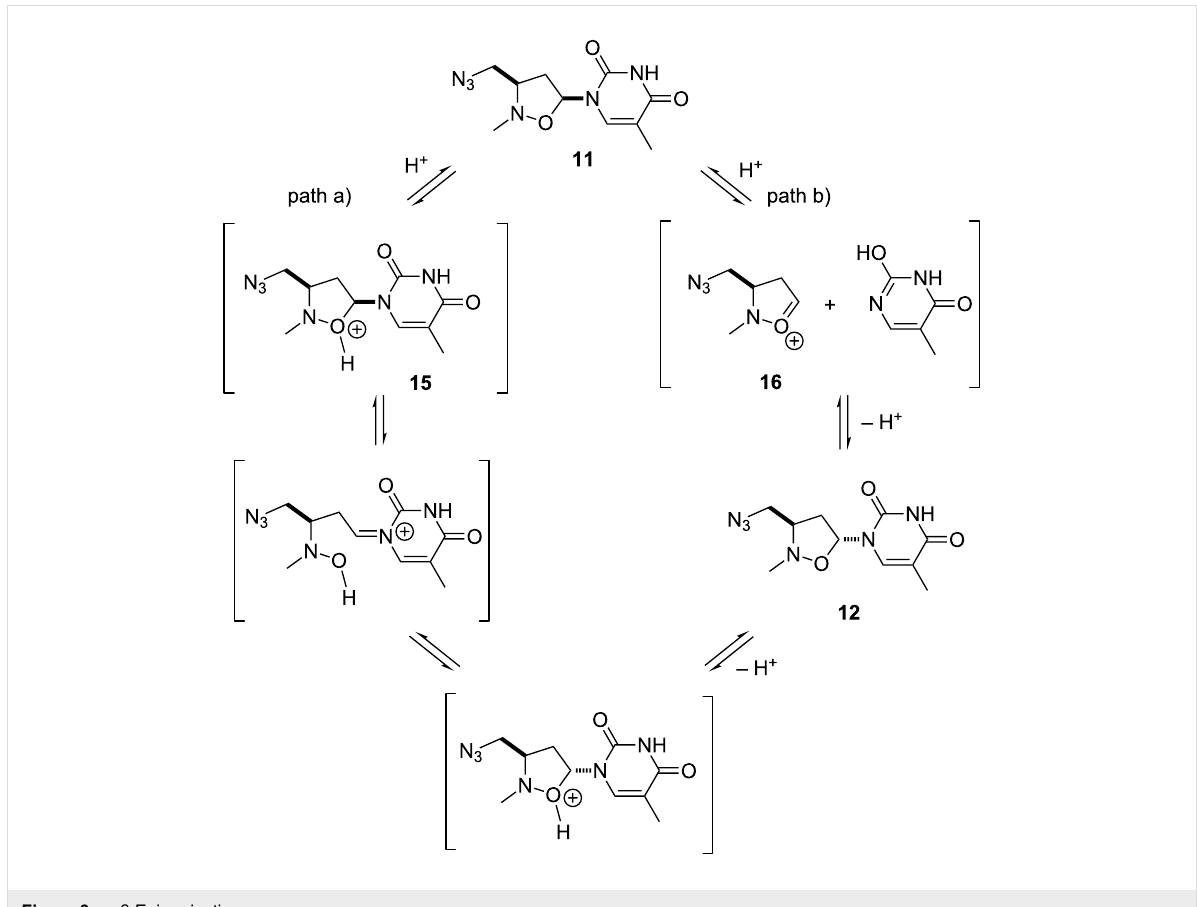
Figure 3: α – β Epimerization.